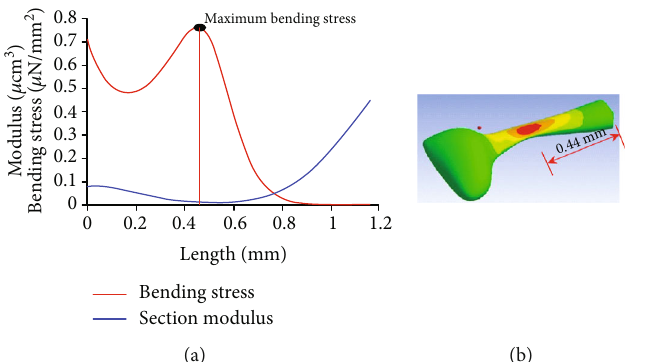
Figure 13: Stress variation along the length of the haltere. (a) Analytically calculated. (b) Calculated using FEM analysis considering solid cross-section.